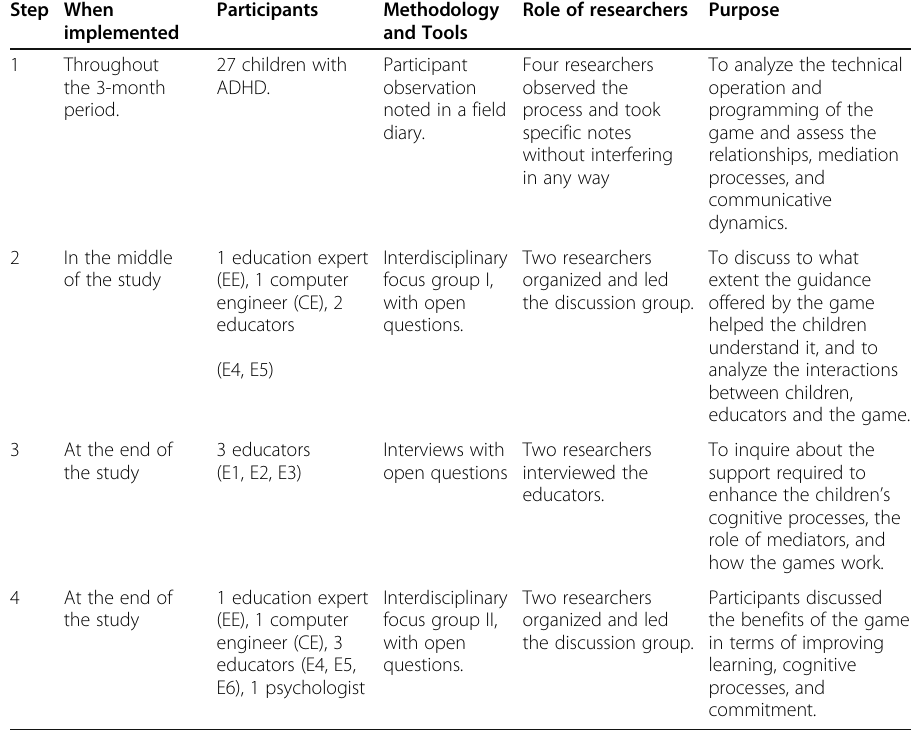
Table 2 Sources, methods, and times for collecting